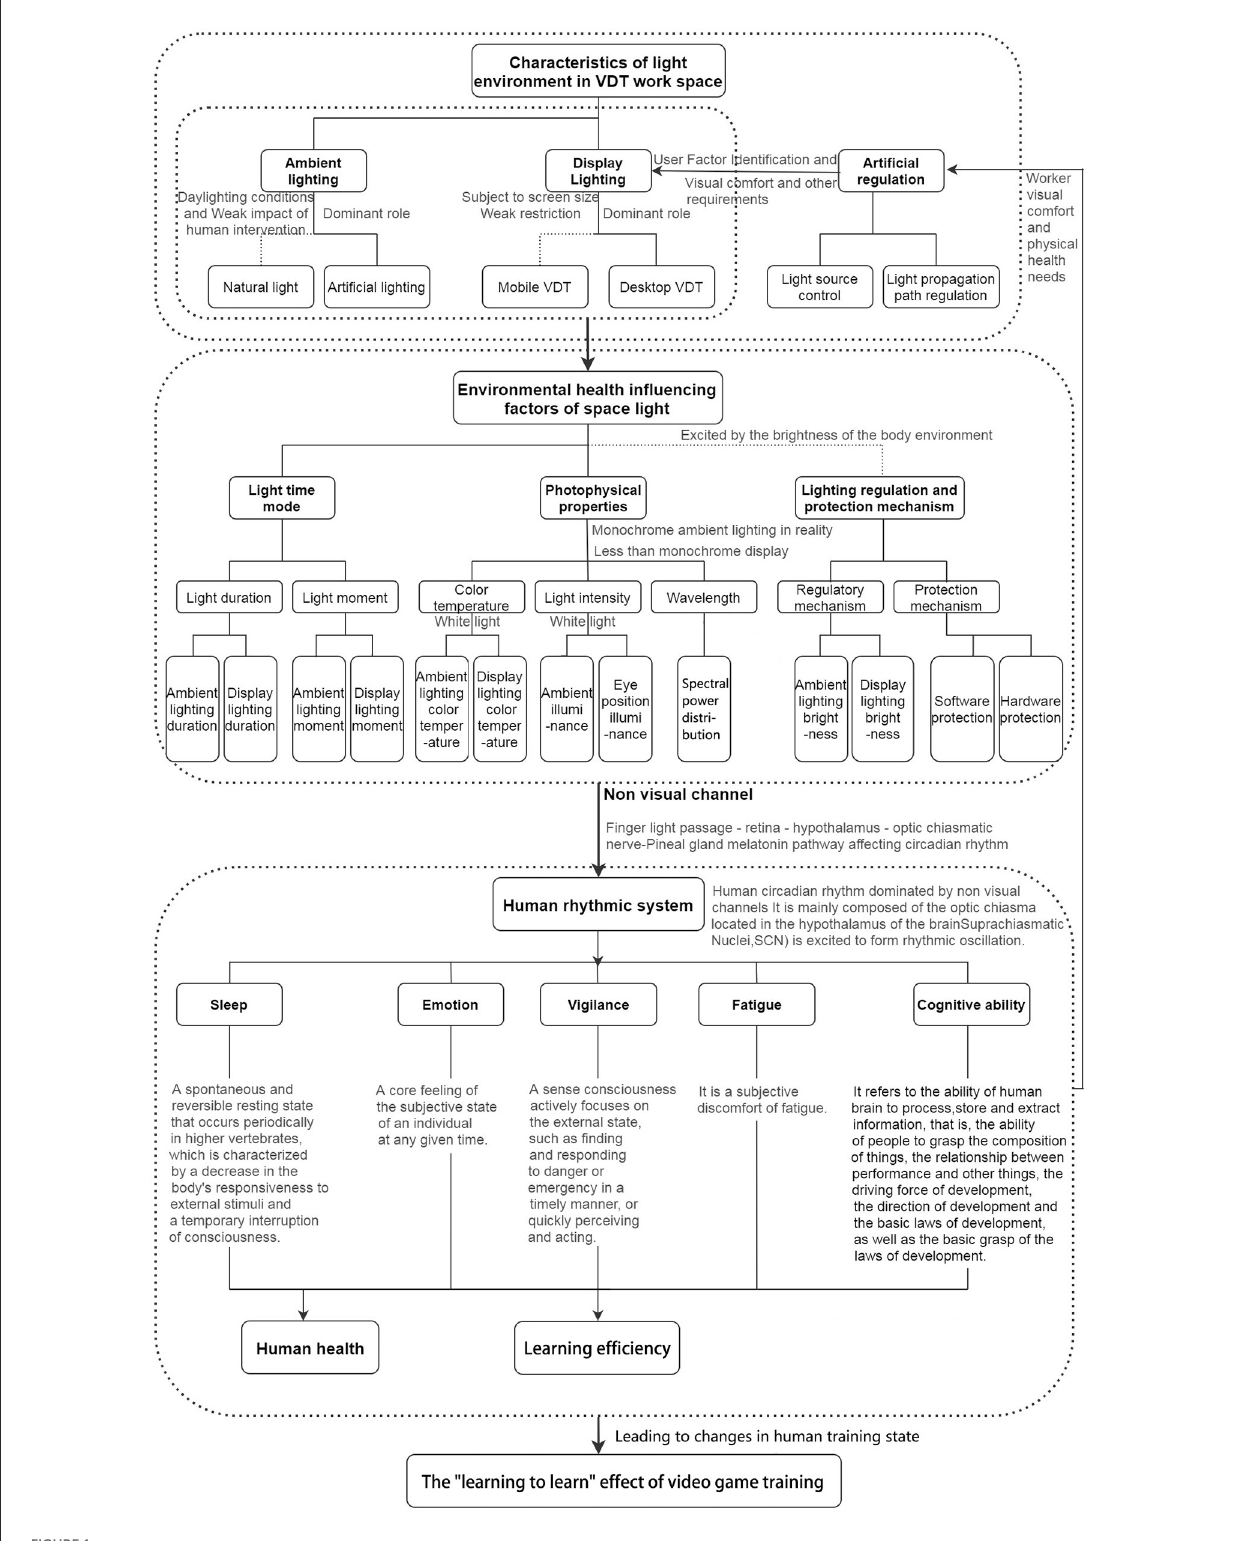
FIGURE1 The relationship between the mechanism of working space light environment on the “learning to learn” effect of video game training.